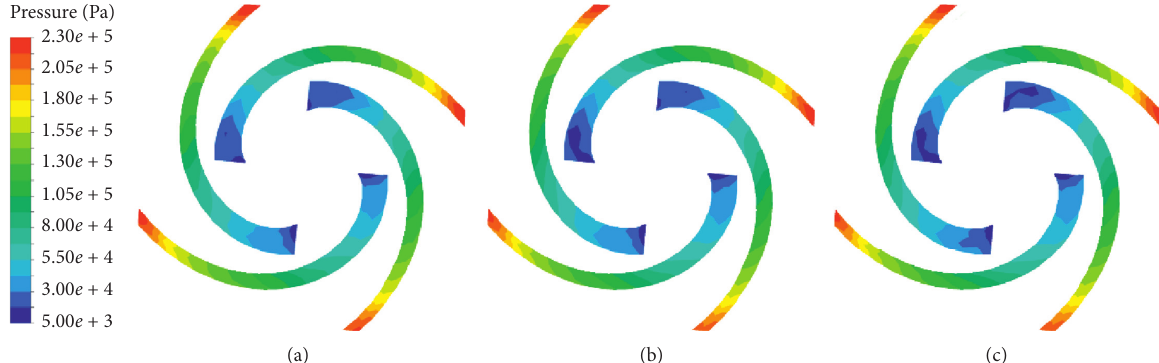
Figure 10: Pressure distribution on the pressure surface of the impeller: (a) 5mm, (b) 10mm, and (c)